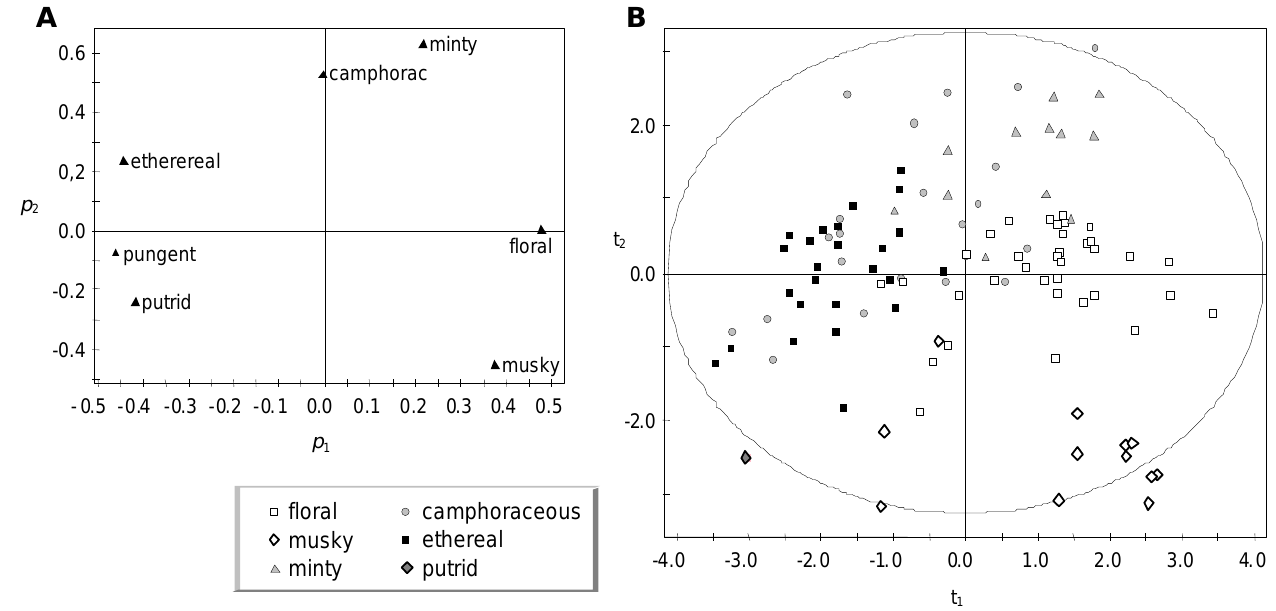
Figure 2. Results from the PCA performed with the database obtained by Amoore and Venstrom [39]. Prior to the analysis, variables were transformed for normality, and then mean-centered and scaled to unit variance. (A) Loading plot (p (t vs. t ) for the first and second principal components. White squares represent the 2 1 samples that were described with highest scores as floral, and so on, according to the caption (the pungent category does not appear because none of the samples was primarily described as